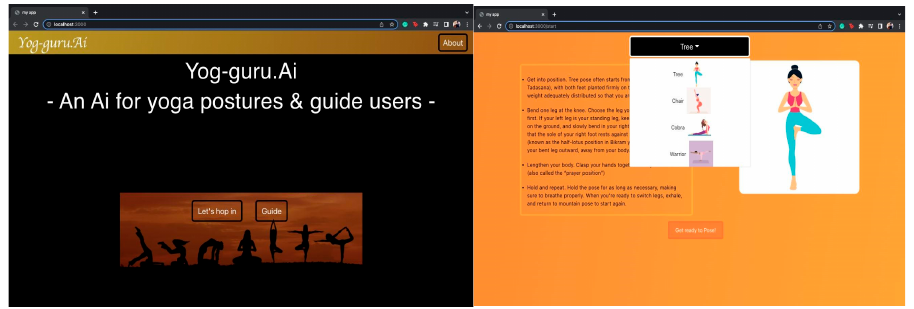
Figure 11. The home page and the user guide on various poses of the Y_PN-MSSD model.